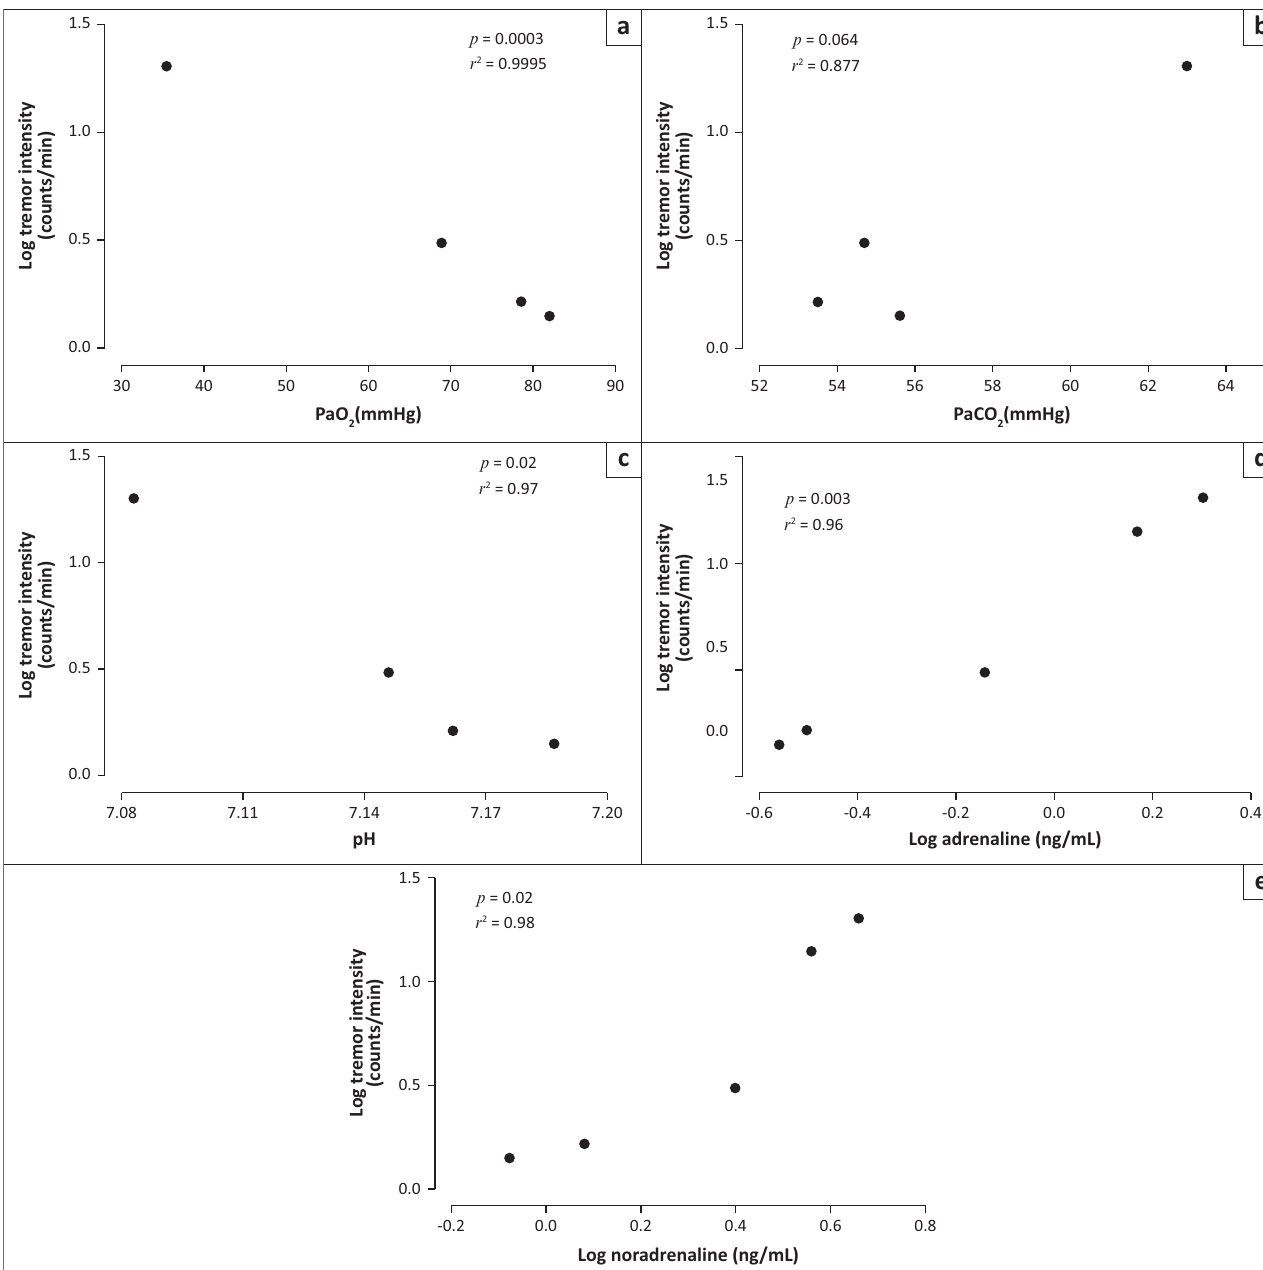
FIGURE 2: Fourteen free-ranging white rhinoceros were chemically immobilised with a combination of etorphine and azaperone. Six minutes after the animals were placed in lateral recumbency, they received a combination of butorphanol (IV) and nasotracheal oxygen insufflation. The log mean tremor intensity counts were correlated, using Pearson’s product–moment correlations, with the mean arterial partial pressure of oxygen (a) the mean arterial partial pressure of carbon dioxide (PaCO mean blood pH (c) (measured at 5, 10, 15, 20 and 25 min) and the mean log-transformed adrenaline (d) and noradrenaline (e) concentrations (measured at 1, 5, 10, 15, 20 and 25